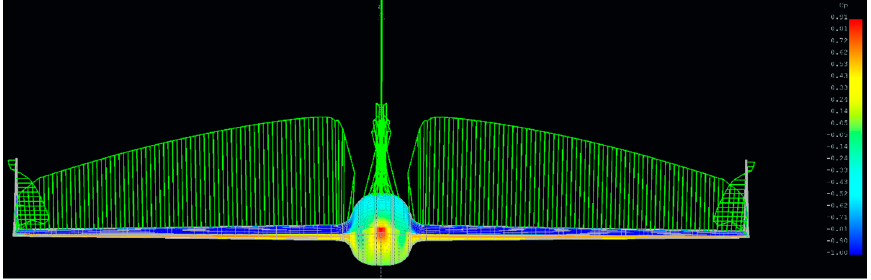
Figure 3. Isometric view of HORNET and fuselage with cross-sections defining its geometry.